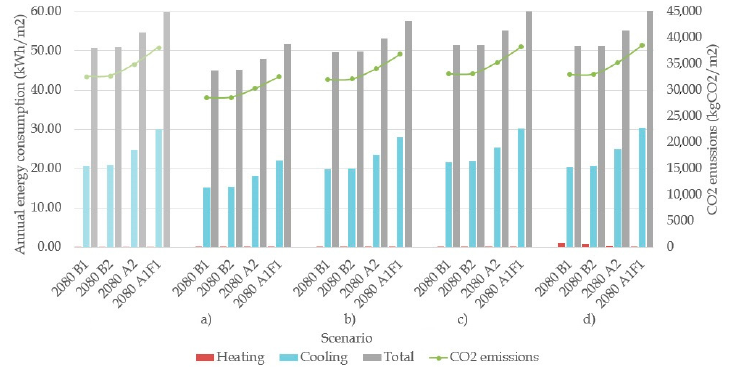
Figure 9. Variation of energy consumption and CO 2 emissions in the adaptation models of 2080 scenario: ( a ) with the improvement in the efficiency of HVAC; ( b ) with the control of the quality of